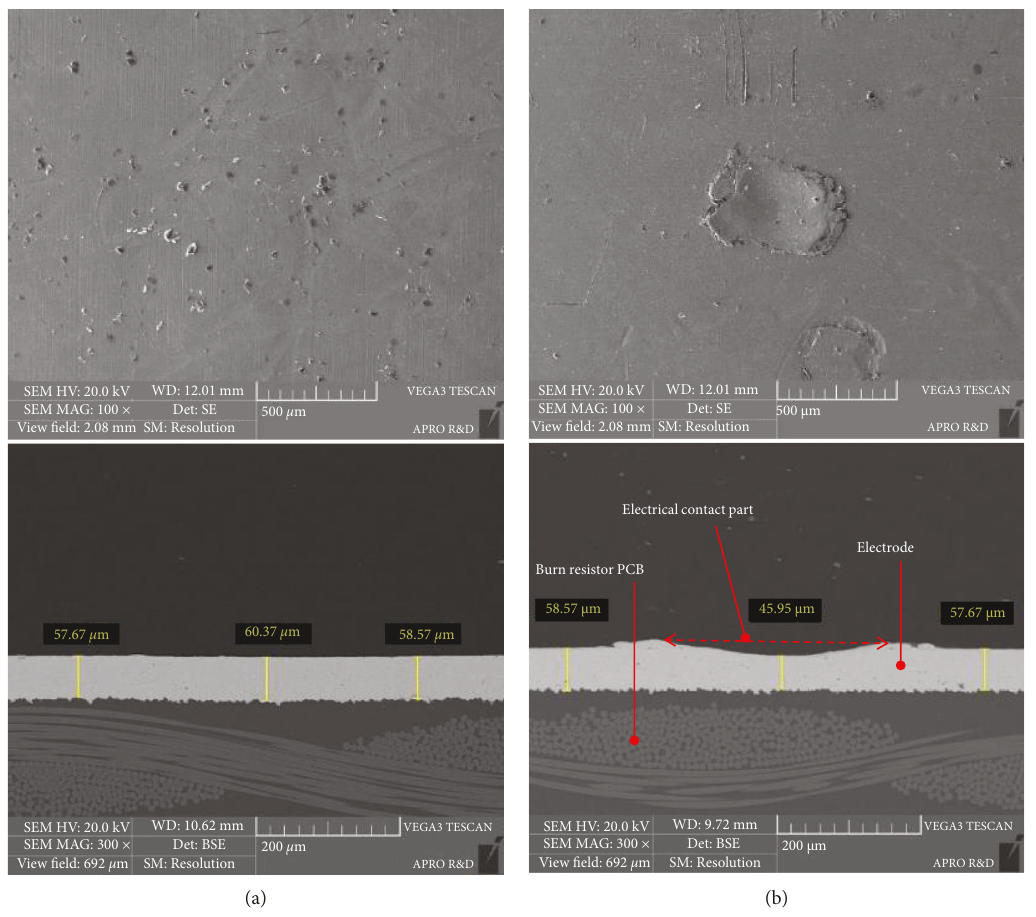
Figure 16: SEM microphotographs of the electrodes of the burn resistor PCB: (a) pretest and (b)